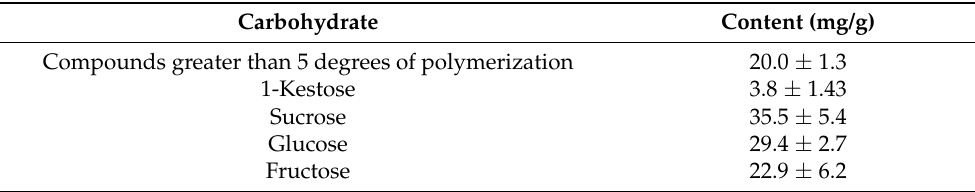
Table 3. Carbohydrate composition of jackfruit seed